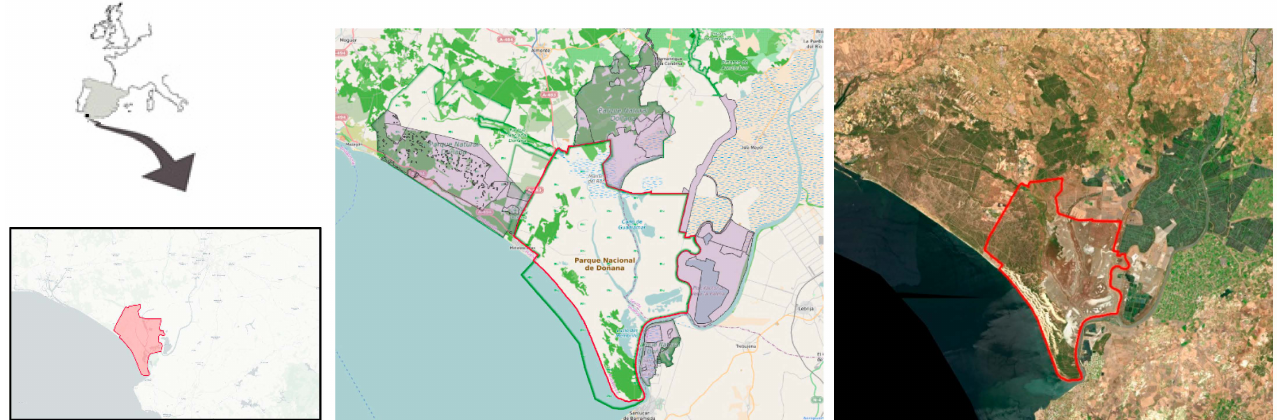
Figure 1. Doñana National Park (red) and protected areas of the Natural Park (purple): situation and boundary